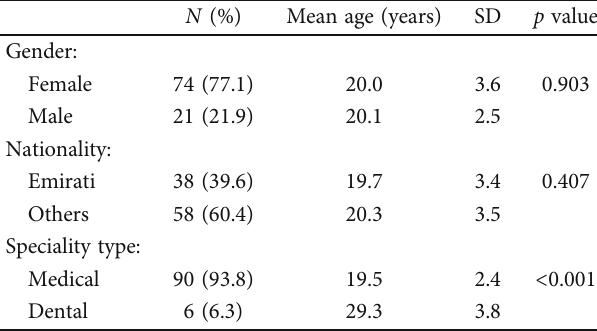
Table 1: The distribution of study subjects by sociodemographic variables and the mean